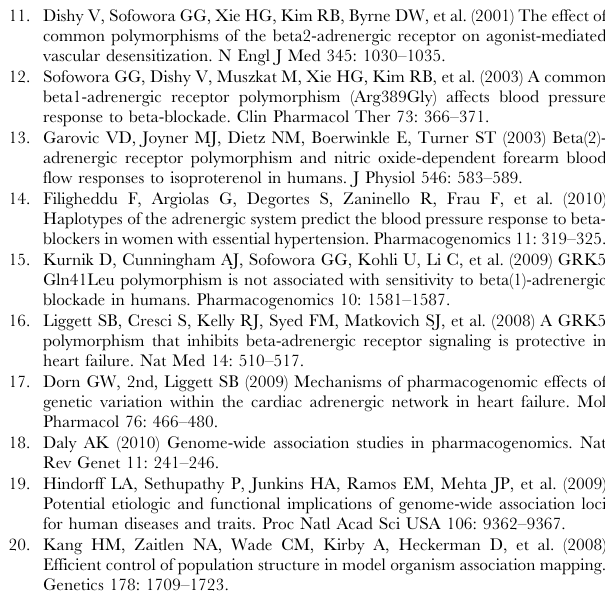
Table S3 Suggestive and significant hits mapped for the 27 traits. For each SNP, the association scores are given as the negative logarithm of the p -values calculated in EMMA, across the 105 genome-wide scans (columns K to DK). The data are ranked by position, from chr 1 to chr 17 (rows 5 to 391). Table S4 Suggestive and significant hits mapped for the effects of the treatments. For each SNP, the association scores are given as the negative logarithm of the p -values calculated in EMMA across 201 genome-wide scans (columns L to HD). The data are ranked by position, from chr 1 to chr 19 (rows 4 to 217). Table S5 Log 2 normalized cardiac expression values of the main candidate genes. Transcripts were measured by microarrays in the cardiac ventricles of untreated C57BL/6J and KK/HlJ mice (n= 4 per strain). Values were calculated from Affymetrix CEL files using the RMA algorithm. Data are listed by probeset and are ranked by